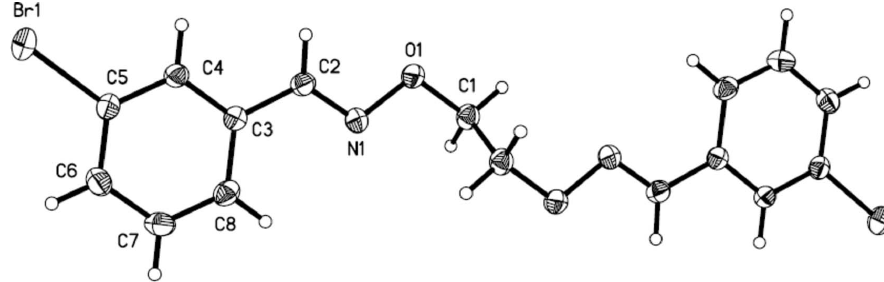
Figure 1 The molecular structure of the title compound with atom numbering scheme [Symmetry codes: - x - 1,- y ,- z ]. Displacement ellipsoids for non-hydrogen atoms are drawn at the 30% probability